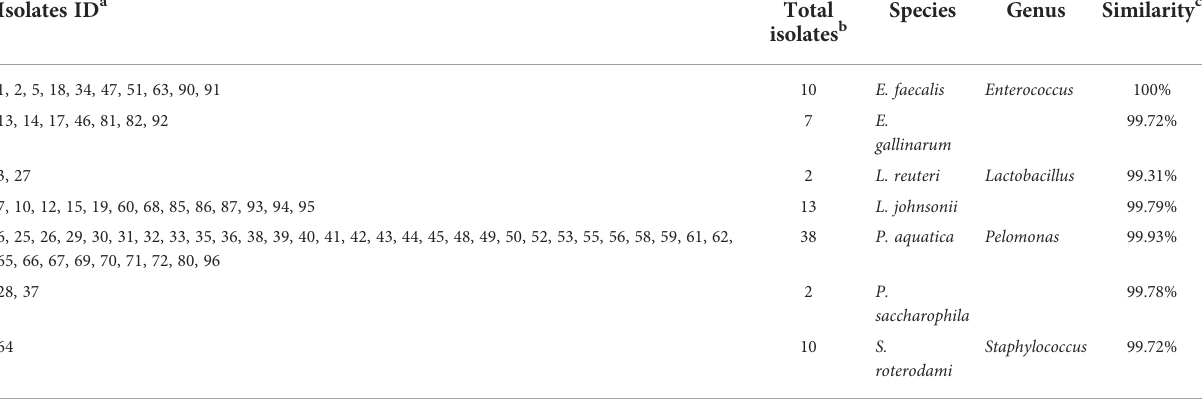
TABLE 1 Result of the obtained species using the traditional